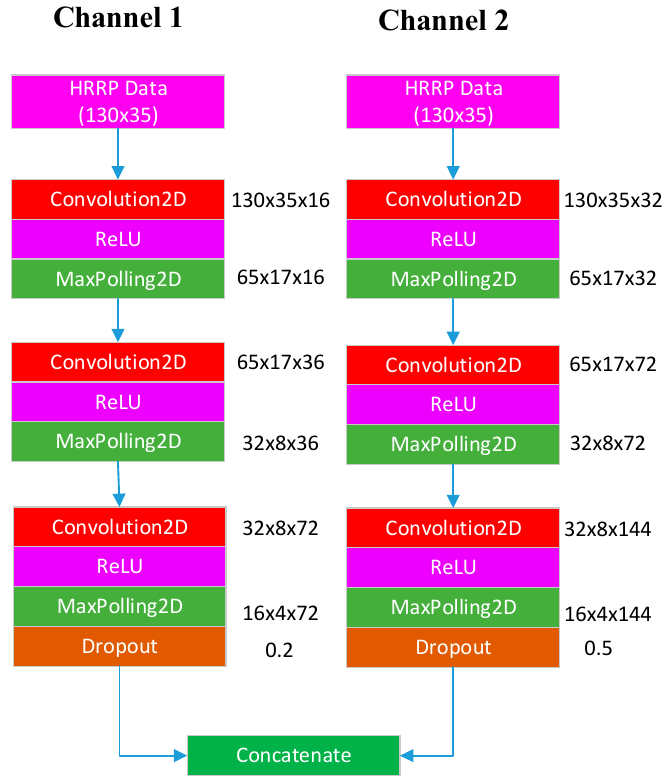
Figure 7. Architecture of the proposed two-channel CNN.